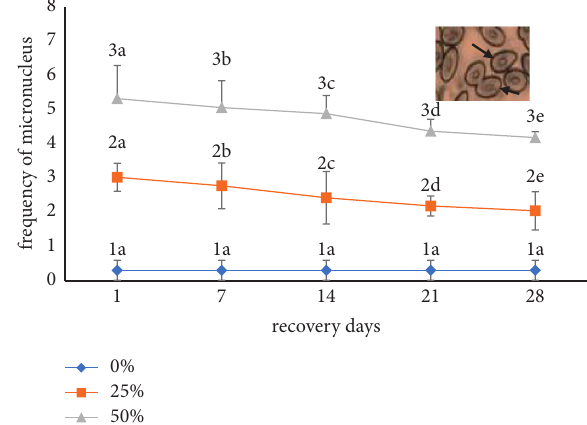
Figure 4: Recovery responses of MN induced by malathion (mean ± SD) at different time intervals in B. gonionotus . Values with different numeric superscripts differ significantly ( p < 0 . 05) between concentrations within a duration in MN recovery. Values with different letter superscripts differ significantly ( p < 0 . 05) be- tween duration within concentration in MN recovery. All values are expressed as mean ± SD. The photograph in the inset shows MN recovery